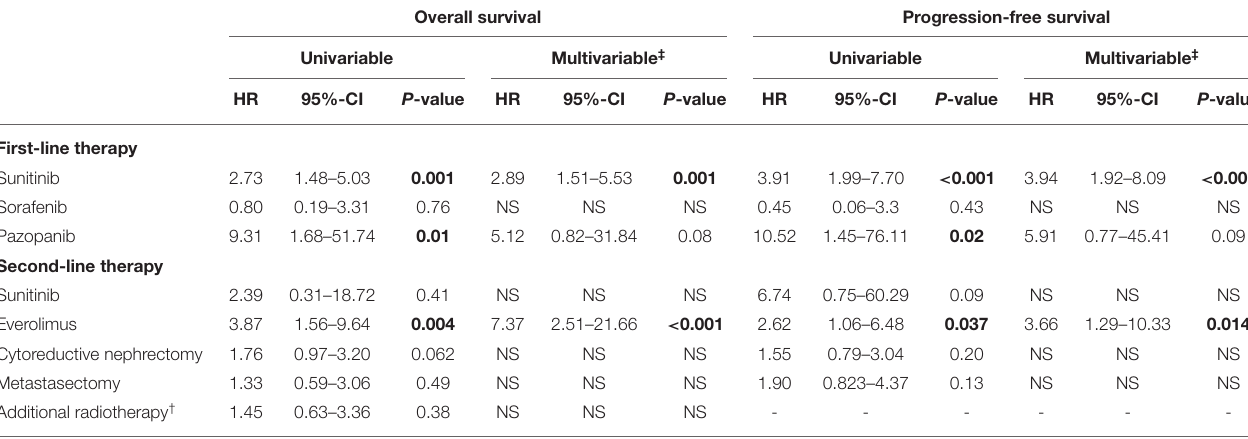
TABLE 3 | Uni- and multivariable analyses of association of sRCC and survival endpoints stratified by most common therapy modalities in patients with mRCC treated with TKIs. Overall survival Progression-free survival Univariable Multivariable